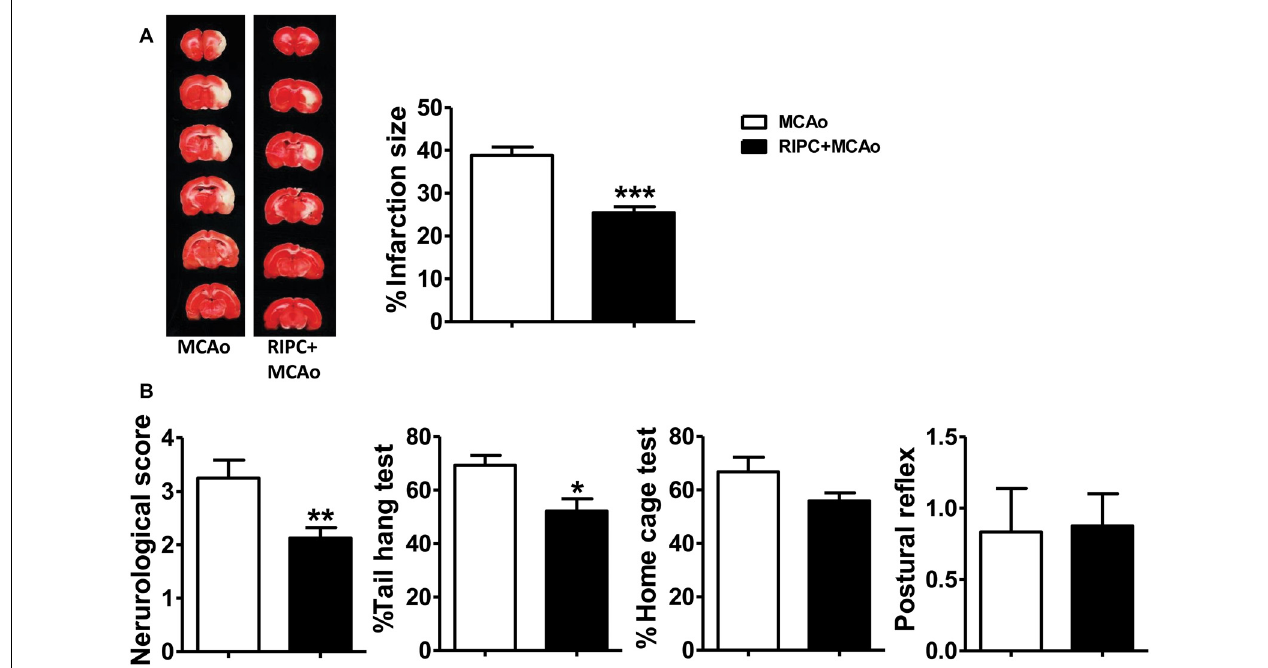
FIGURE 1 | Remote ischemic preconditioning (RIPC) reduced infarct size and improved neurological function and the behavioral test after stroke in aged rats. (A) Representative images and infarct volume of 2,3,5-triphenyl-2H-tetrazolium chloride (TTC) staining in the MCAo and RIPC+MCAo group in aged rats. (B) Neurological score and behavior tests. Statistical analysis was performed by ANOVA. * , ** , *** vs. MCAo, p < 0.05, 0.01, 0.001, respectively ( N = 8–10 per group). MCAo, middle cerebral artery occlusion; RIPC, remote ischemic preconditioning.